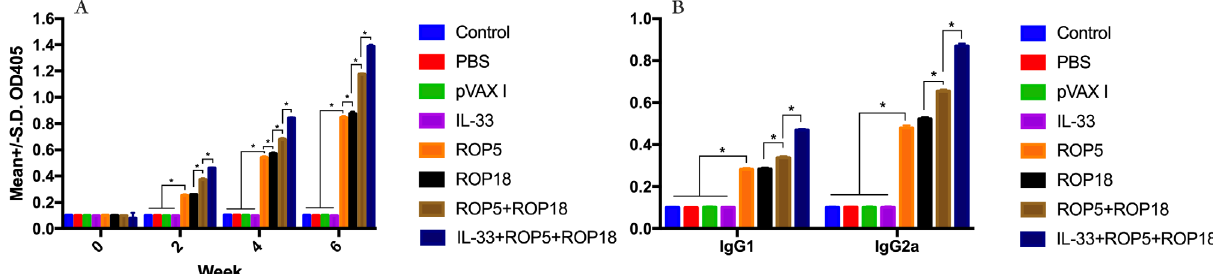
Figure 1. Detection of IgG, IgG1, and IgG2a antibodies in the sera of Kunming mice. (A) Determination of IgG antibodies induced by DNA immunization at weeks 0, 2, 4, 6. (B) Determination of IgG1 and IgG2a in the sera of mice two weeks after the last immunization. Results are expressed as means ± SD ( n = 3) with respect to absorbance at OD405 and statistical differences ( p < 0.05) are indicated by (*). The bars represent the levels of IgG, IgG1, and IgG2a in the serum of mice.